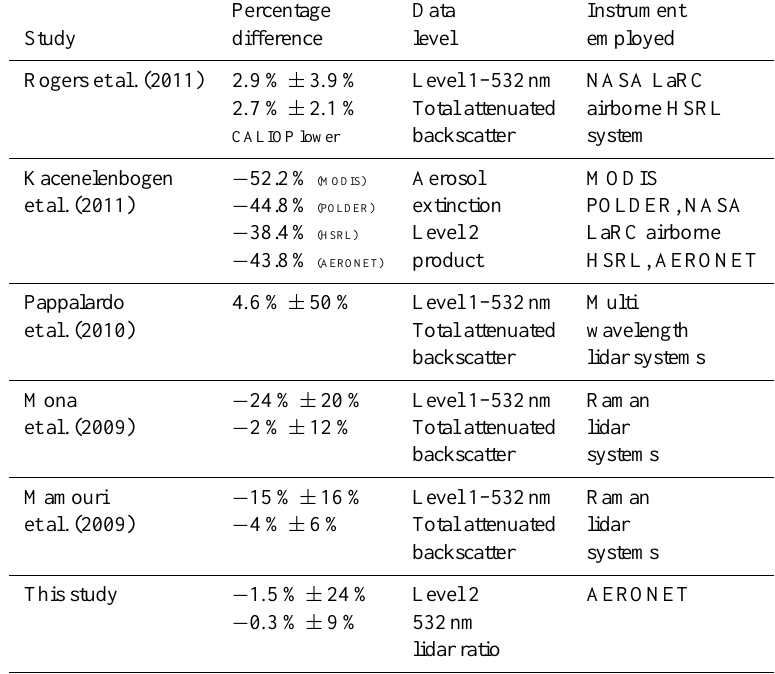
Table 9. Summary of CALIOP validation results from previous